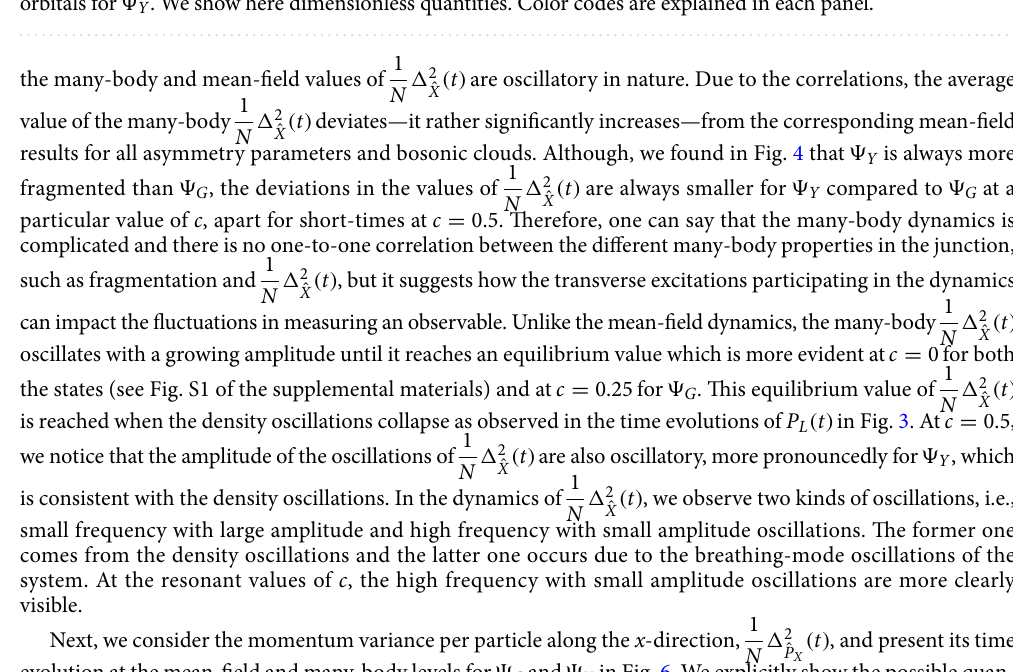
1 � 2 ( t ) , in a N P X ˆ 10 = 1 � 2 ( t ) at the resonant N P X ˆ 1 signifies the mean-field results. The = 10 time-dependent =